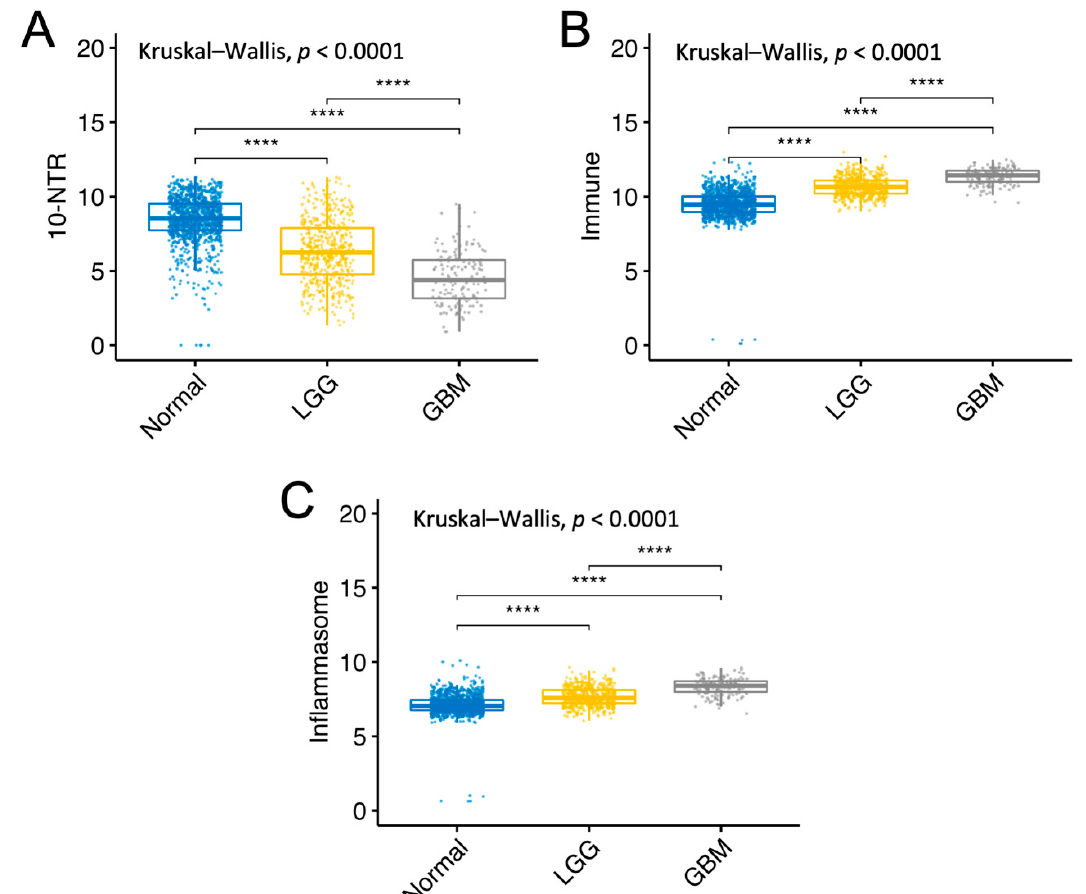
Figure 7. Gene expression levels of the 10-NTR, immune, and inflammasome gene panels in normal, LGG, and GBM tissue. ( A ) The average expression of the 10-NTR genes is plotted against different tissue types: normal, LGG and GBM. ( B ) Average expression of the 36 immune-related genes (IRGs) in the three tissue types. ( C ) Average expression of the 12 inflammasome genes in the three tissue types. Wilcoxon test **** p ≤ 0.0001. Expression levels are measured in Log2 (normalized count + 1).